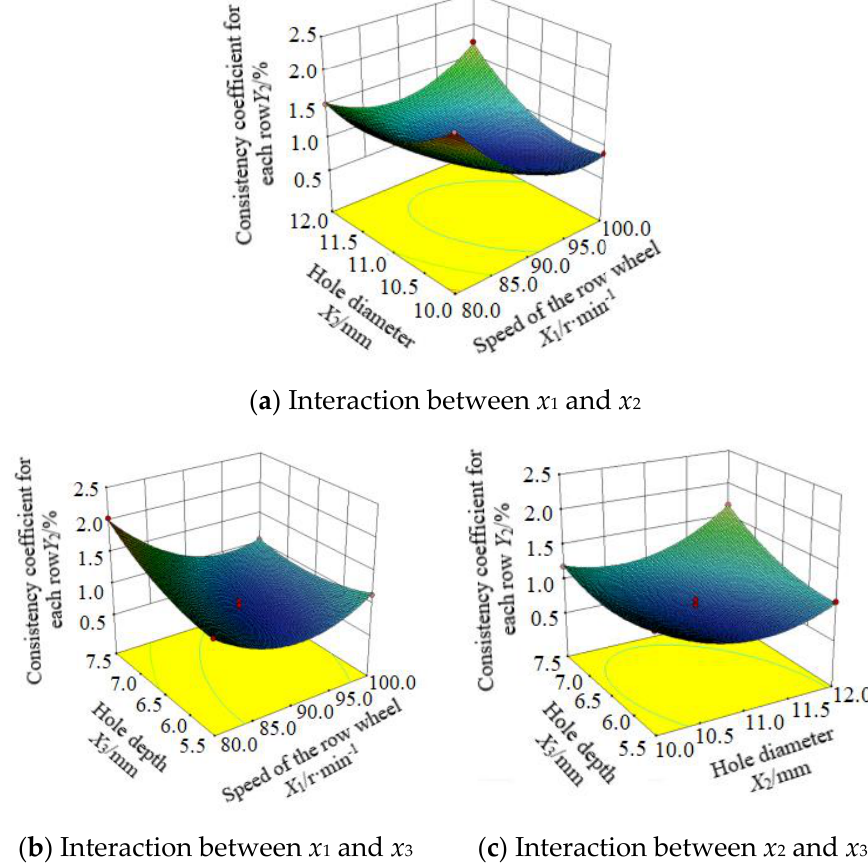
Figure 14. Response surface of the interaction of factors on consistency coefficient for each row.